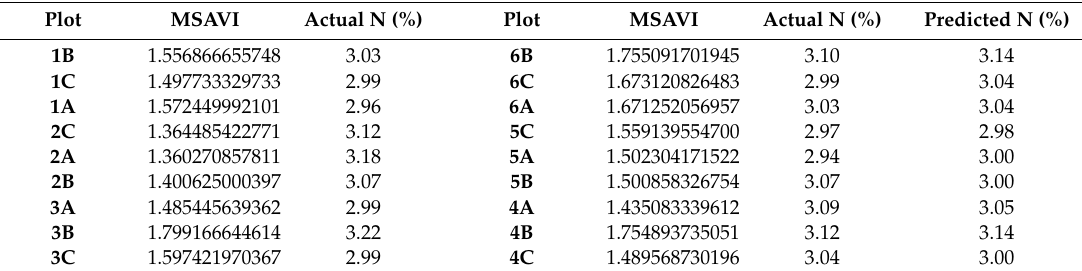
Table 10. Predicted nitrogen concentration